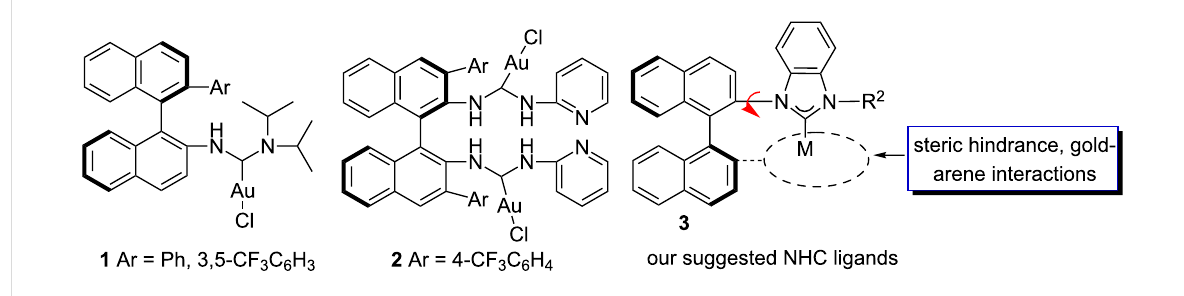
Figure 1: Monodentate chiral NHC gold catalysts in recent years.